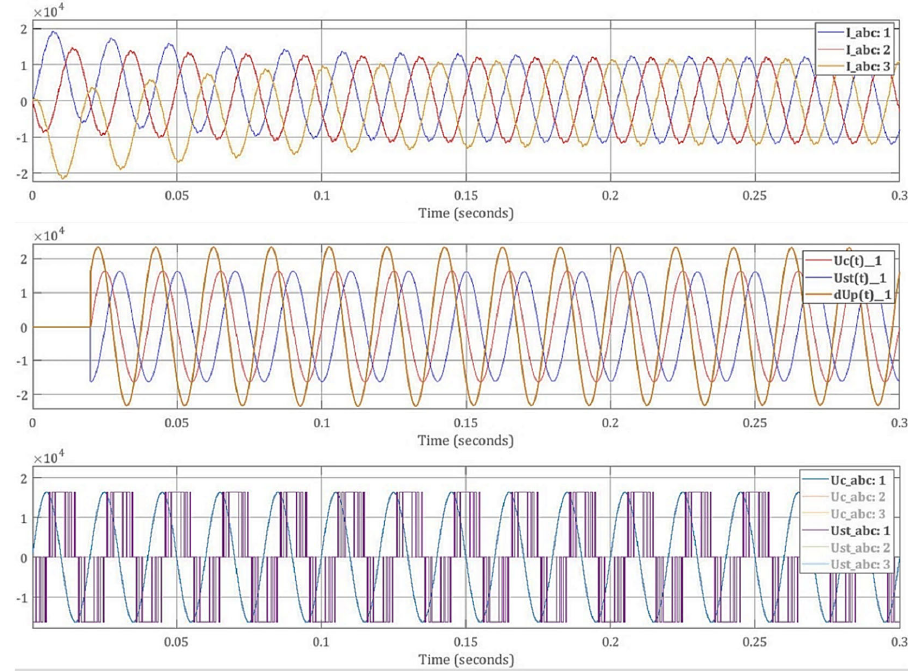
Figure 10. α = 270°, kUst = 1—active and reactive power consumption.